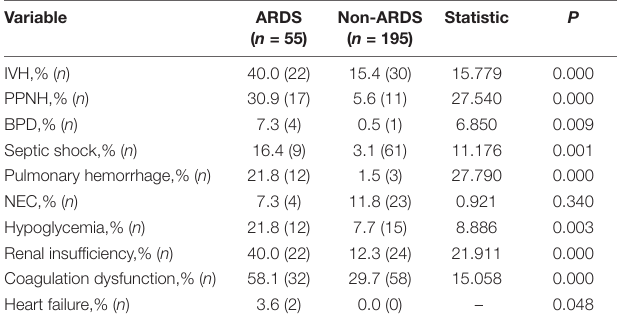
TABLE 3 | Comparison of neonatal complications between the two groups of infants. Variable